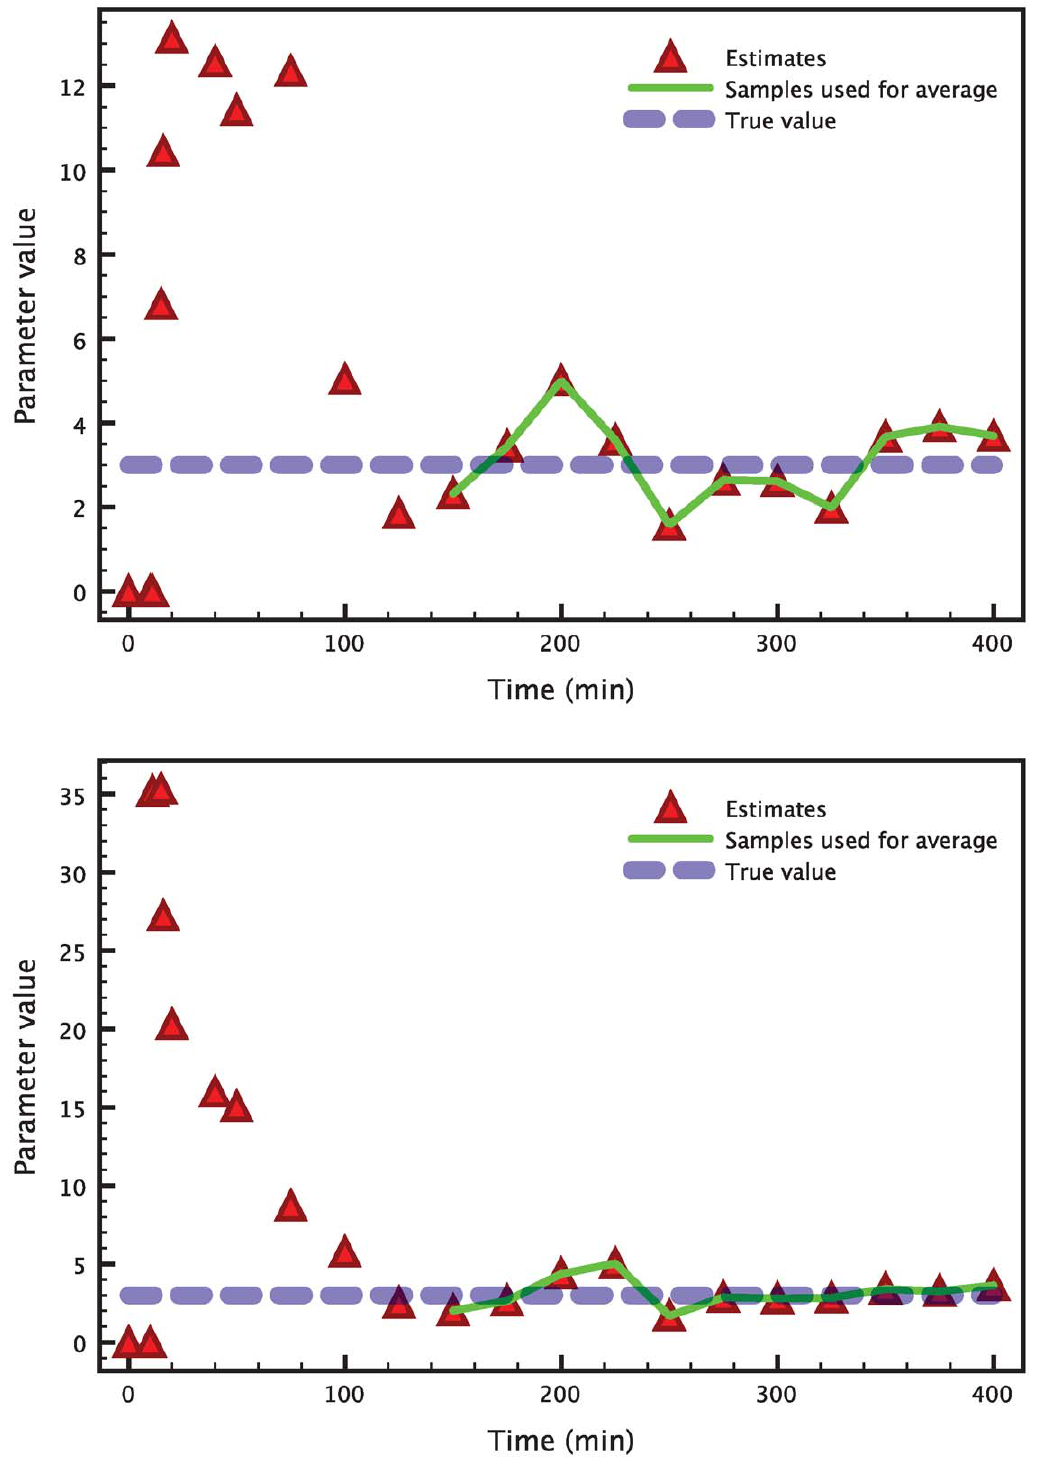
Figure 3. Time evolution of the Kalman filter parameter estimates in the heat shock model. After an initial transient, the estimates of the two parameters a s (top) and K d (bottom), represented by the triangles, keep oscillating around the respective true values (blue dashed line). The last 10 samples (connected by the green line) are averaged to extract a single number from this time-varying signal.